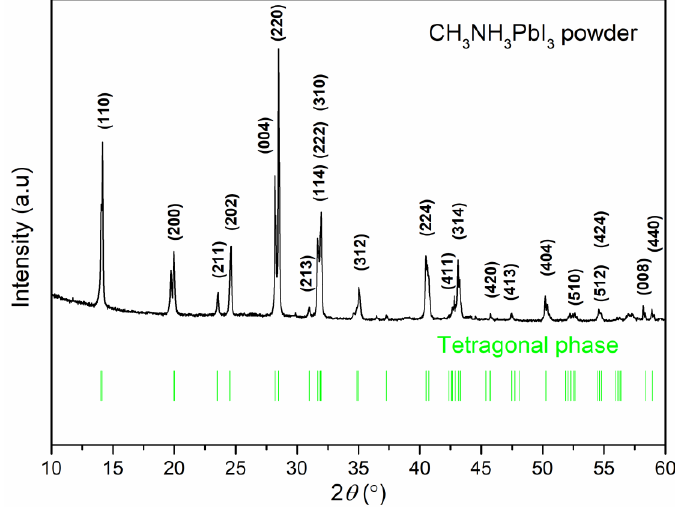
Figure 1. XRD pattern of the CH 3 NH 3 PbI 3 powder and its corresponding data of tetragonal phase.